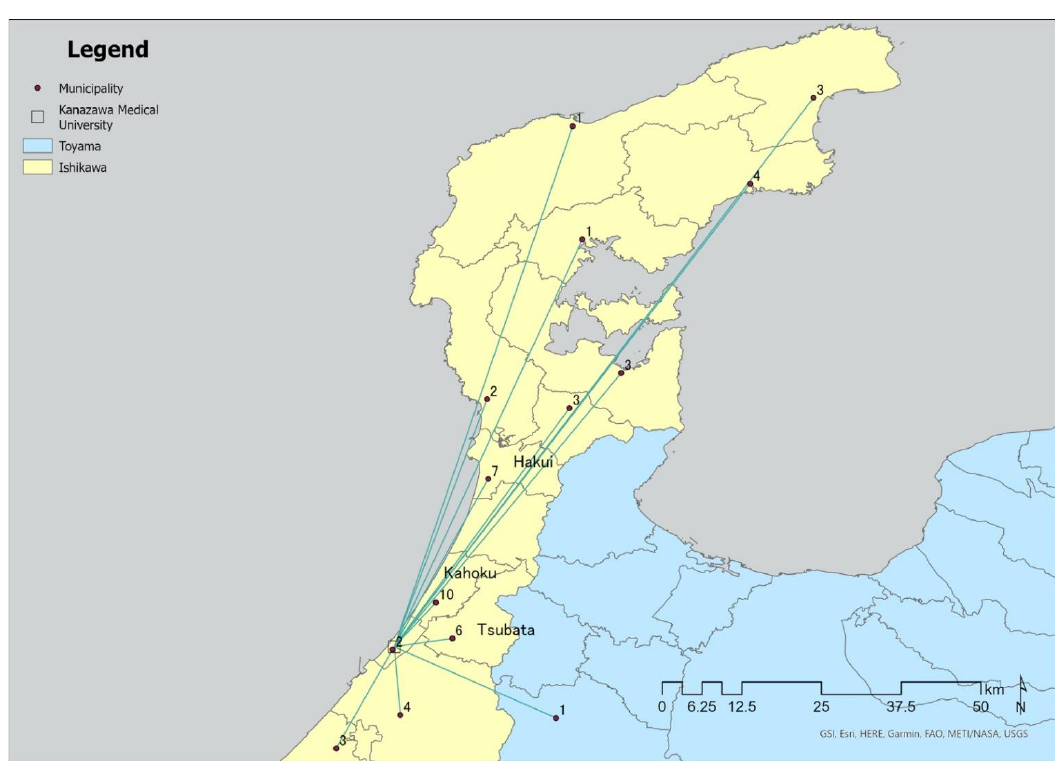
Figure 2. Spider graph.